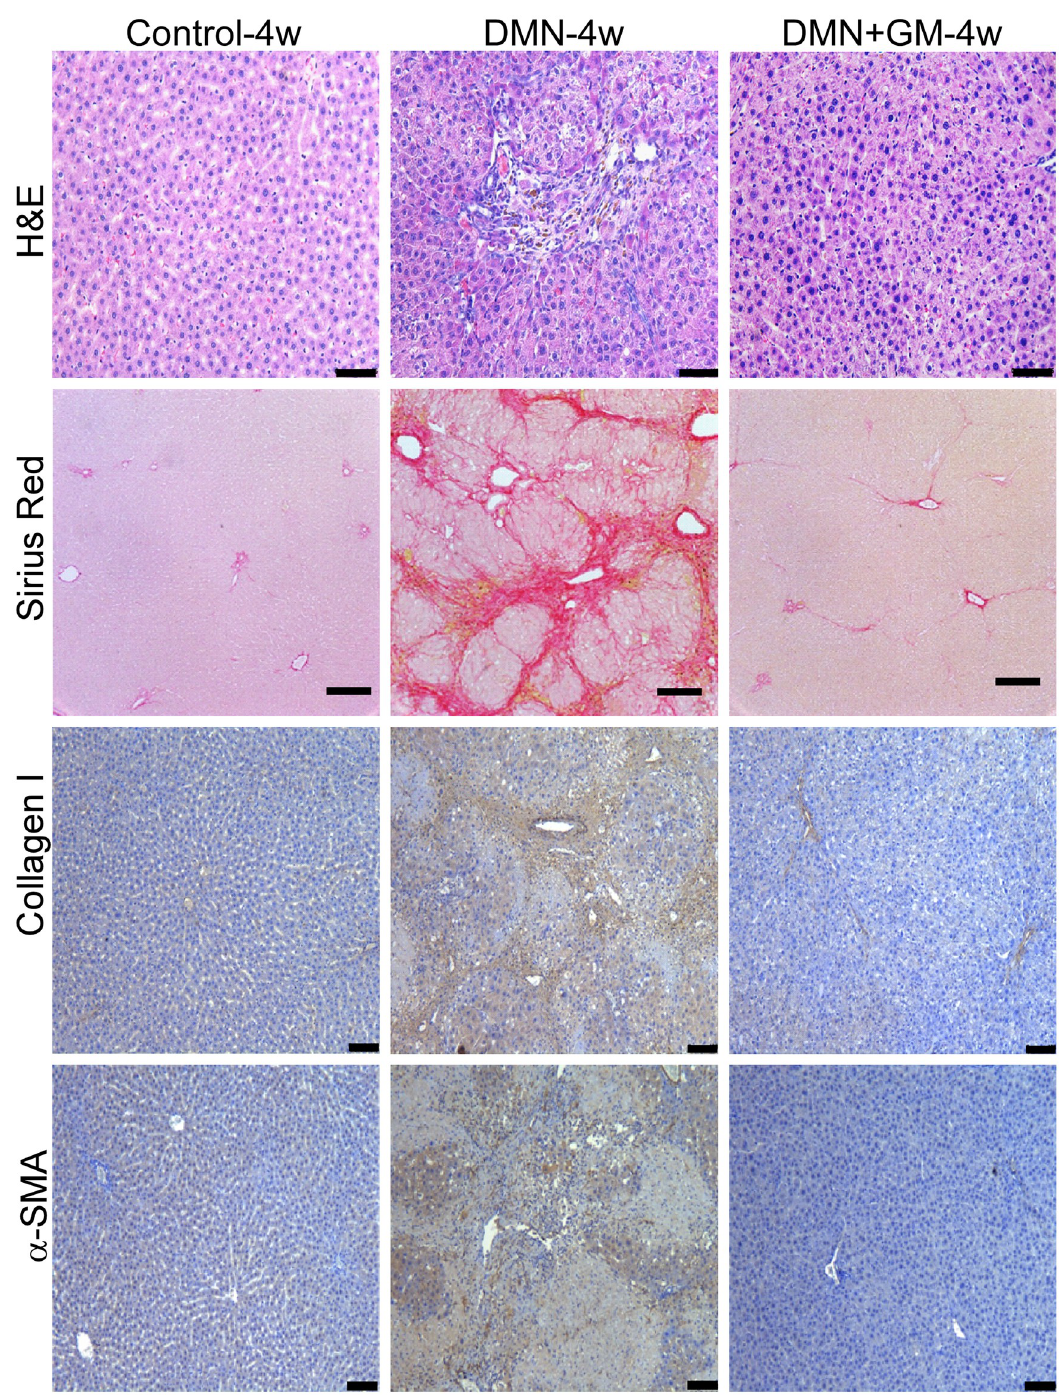
Fig 1. Effects of GM-CSF on DMN-induced histopathological changes in the 4-week group. Liver tissues were collected 29 days after initial DMN administration and fixed in 10% neutral formalin. Thin sections (5 μ m) were cut and stained with hematoxylin and eosin (H&E) and Sirius Red. Collagen type I and α -SMA proteins were detected immunohistochemically. Scale bar = 100 μ m.